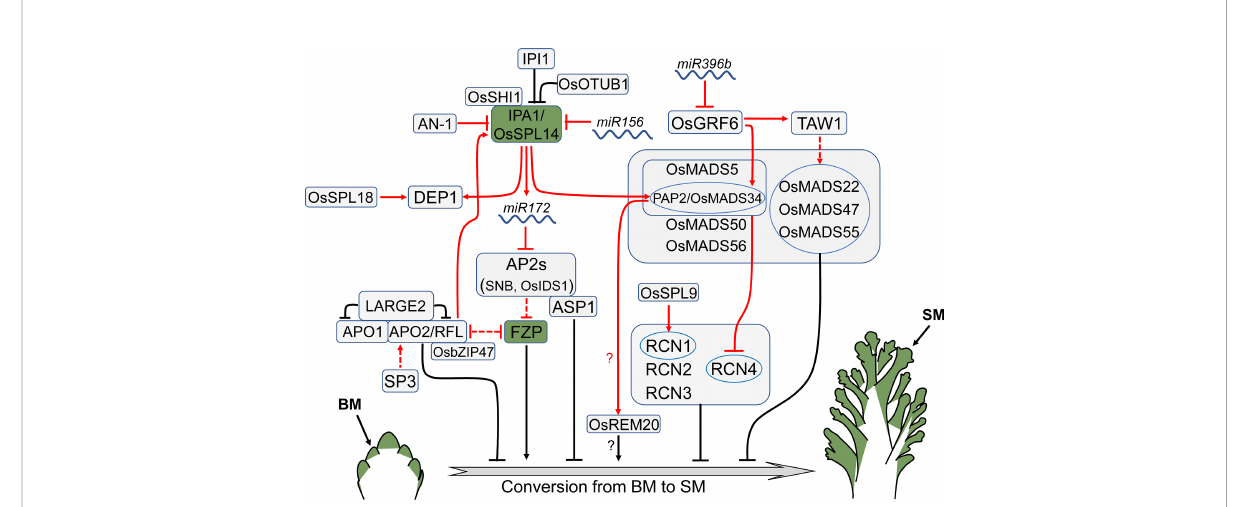
FIGURE 3 Regulators that control meristem identity conversion. FZP promotes the conversion of BM to SM, and its expression indicates that the meristem has acquired terminal identity. IPA1 , also known as WFP / OsSPL14 , is an important rice yield regulator that affects both meristem activity and identity conversion. Arrows and blocked arrows represent positive and negative regulation, respectively. Solid and dashed lines represent direct and indirect regulation, respectively. Red and black lines represent regulation between factors at transcriptional and protein level, respectively. BM, branch meristem; SM, spikelet